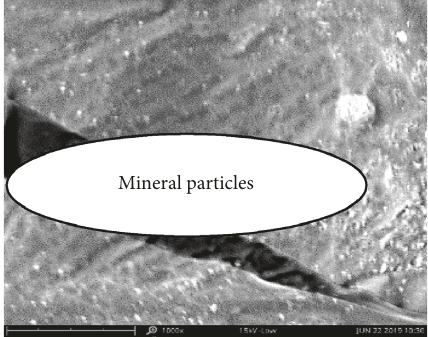
Figure 11: 15% of Buton-modified asphalt.